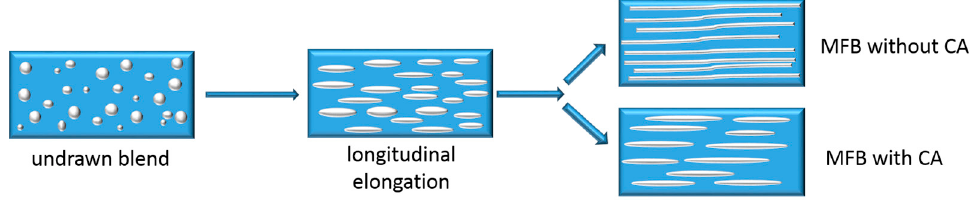
Figure 1. Morphology of blend during cold drawing with and without compatibilizer added during extrusion [4].